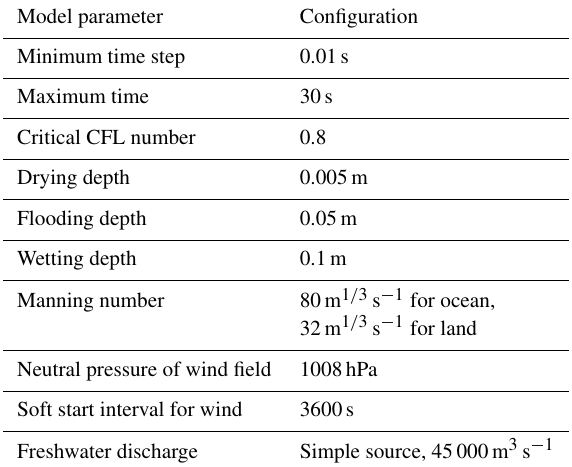
Table 1. Major configuring parameters for the simulation models. CFL signifies